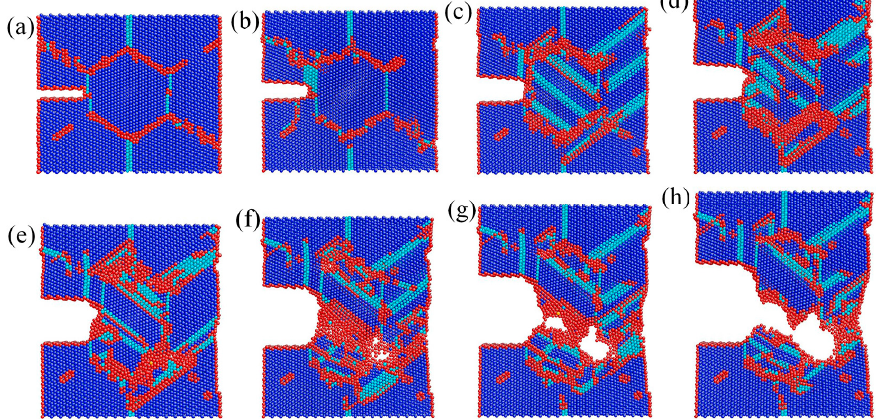
Figure 6. Evolution of atomic configuration for crack propagation in polycrystal nickel at the strain rate of 2 × 10 10 s − 1 : ( a ) ε = 0; ( b ) ε = 0.06; ( c ) ε = 0.12; ( d ) ε = 0.18; ( e ) ε = 0.24; ( f ) ε = 0.36; ( g ) ε = 0.42; ( h ) ε = 0.48. (All the configurations are characterized by CNA, where HCP atoms were displayed by light blue color, FCC atoms were expressed by dark blue color and non-3D-crystalline atoms were exhibited by red color).